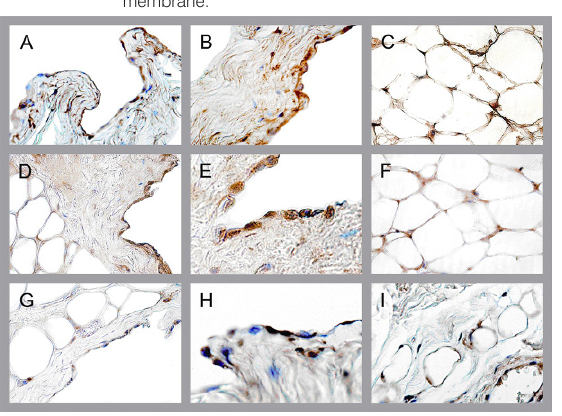
Figure 1. Figure 2. PAI-1, tPA and uPA in human peritoneal membrane.